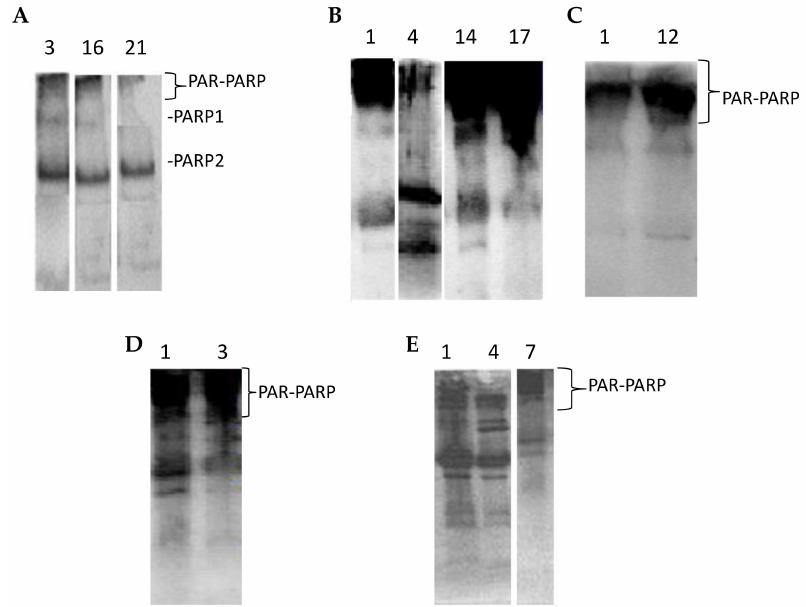
Figure 4. Anti-PARP immunoblottings of lysate cell proteins. ( A ) Controls; volunteers of ( B ) Group 1E; ( C ) Group 2E; ( D ) Group 3E; ( E ) Group IE. Numbers indicate volunteers as in Figures 1–3. The same amount of proteins (20 µ g) was loaded for all